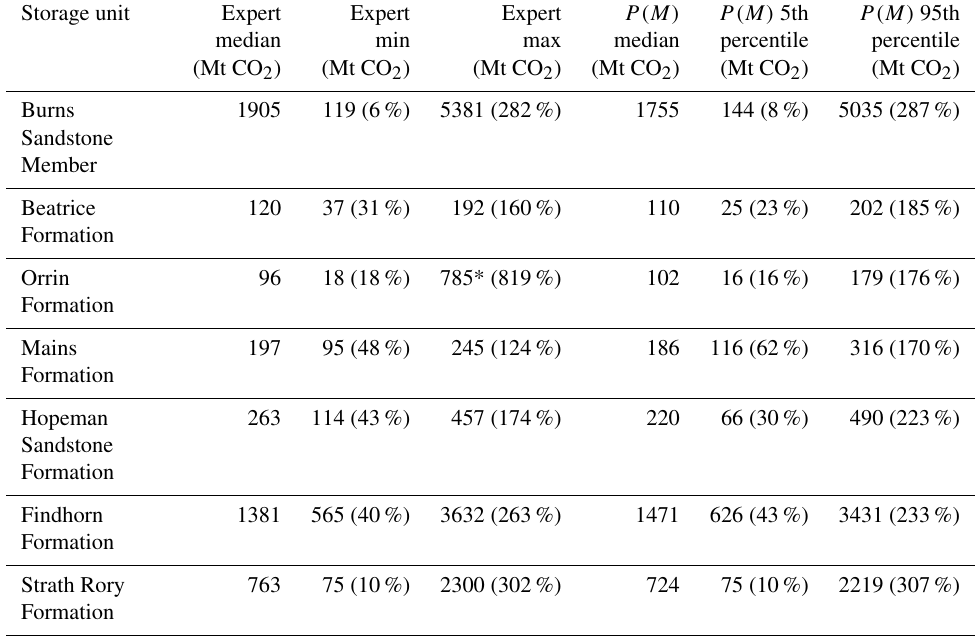
Table 1. Range of individual expert and distribution ( P(M) ) estimates of storage capacity. Numbers in brackets are values expressed as a percentage of the median. Raw data are available in the Supplement to this article. Raw data are available in the Supplement to this